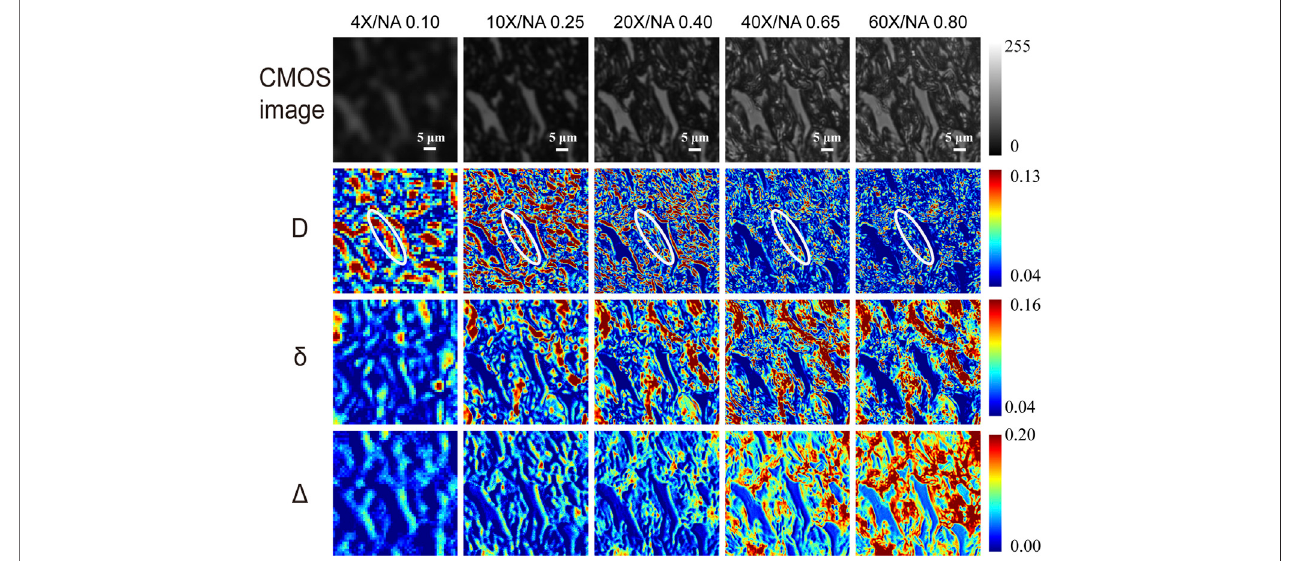
FIGURE 2 | The fi rst row shows the unpolarized light intensity images of the unstained tissue slice under different magni fi cation objectives (4×/NA 0.10, 10×/NA 0.25, 20×/NA 0.40, 40×/NA 0.65, and 60×/NA 0.80). The second to fourth rows show MMPD parameters D , δ , and Δ images of the same region under different magni fi cation objectives. Where the area marked bythe white elliptical line in the D images is an example ofa coarse fi brous structure that is not clear under high NA but obvious under low NA. The unit for δ is radian angle. The white scale bar is 5 μ m.